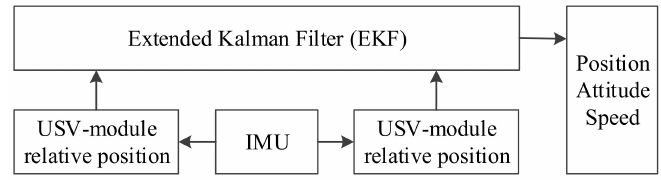
Figure 10. DCM attitude solution program